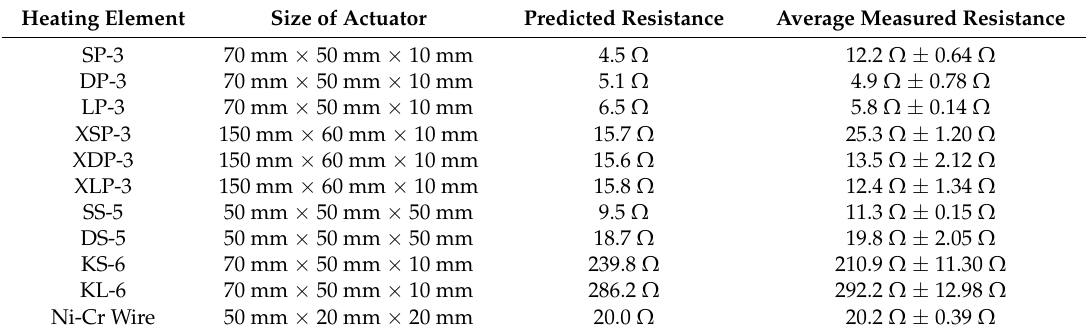
Table 5. Heating Element Pattern Average